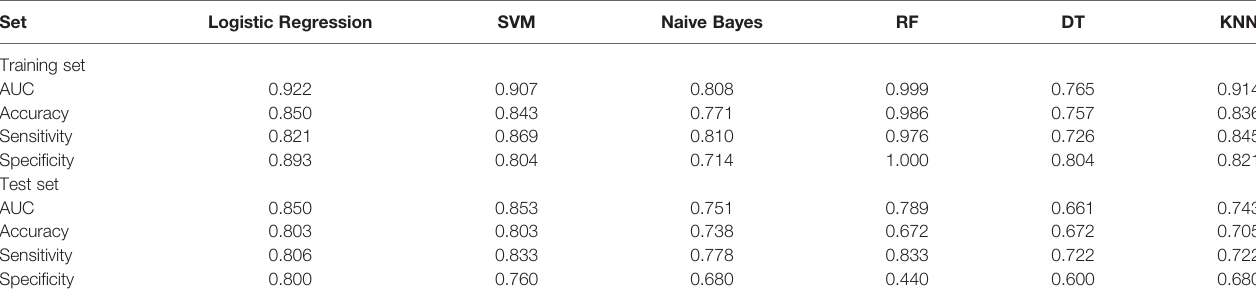
TABLE 3 | The classi fi cation performance of different algorithms.